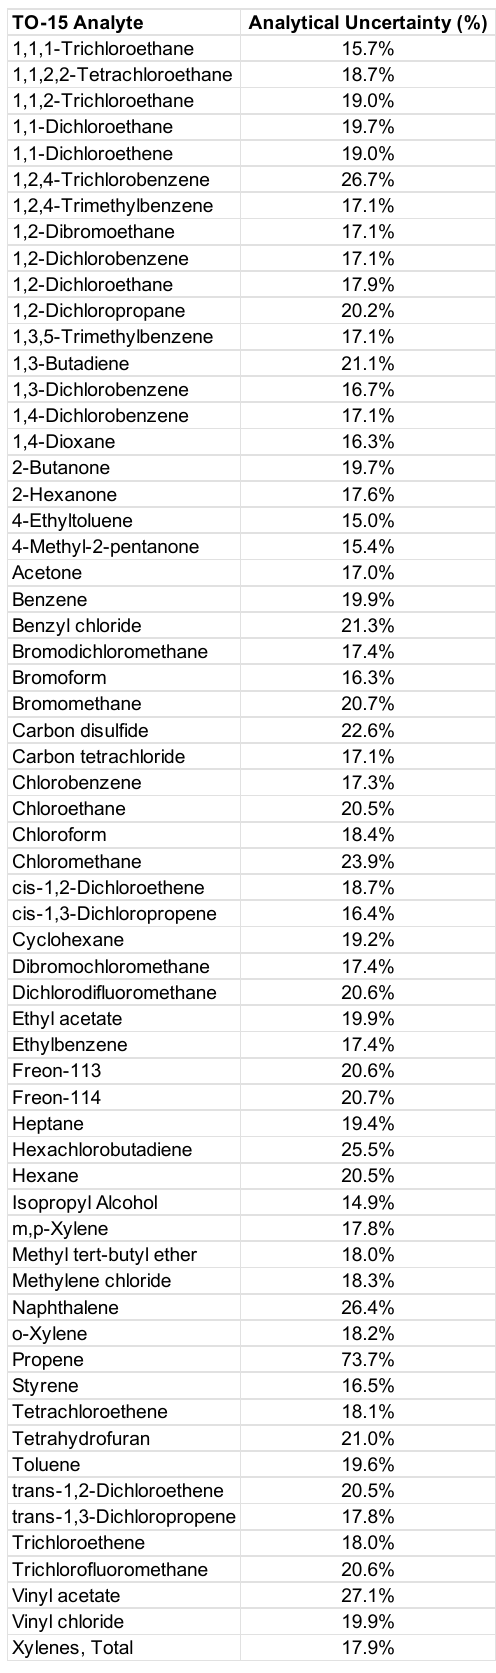
Figure A4. Analytical uncertainties in analytes on the TO-15 list.